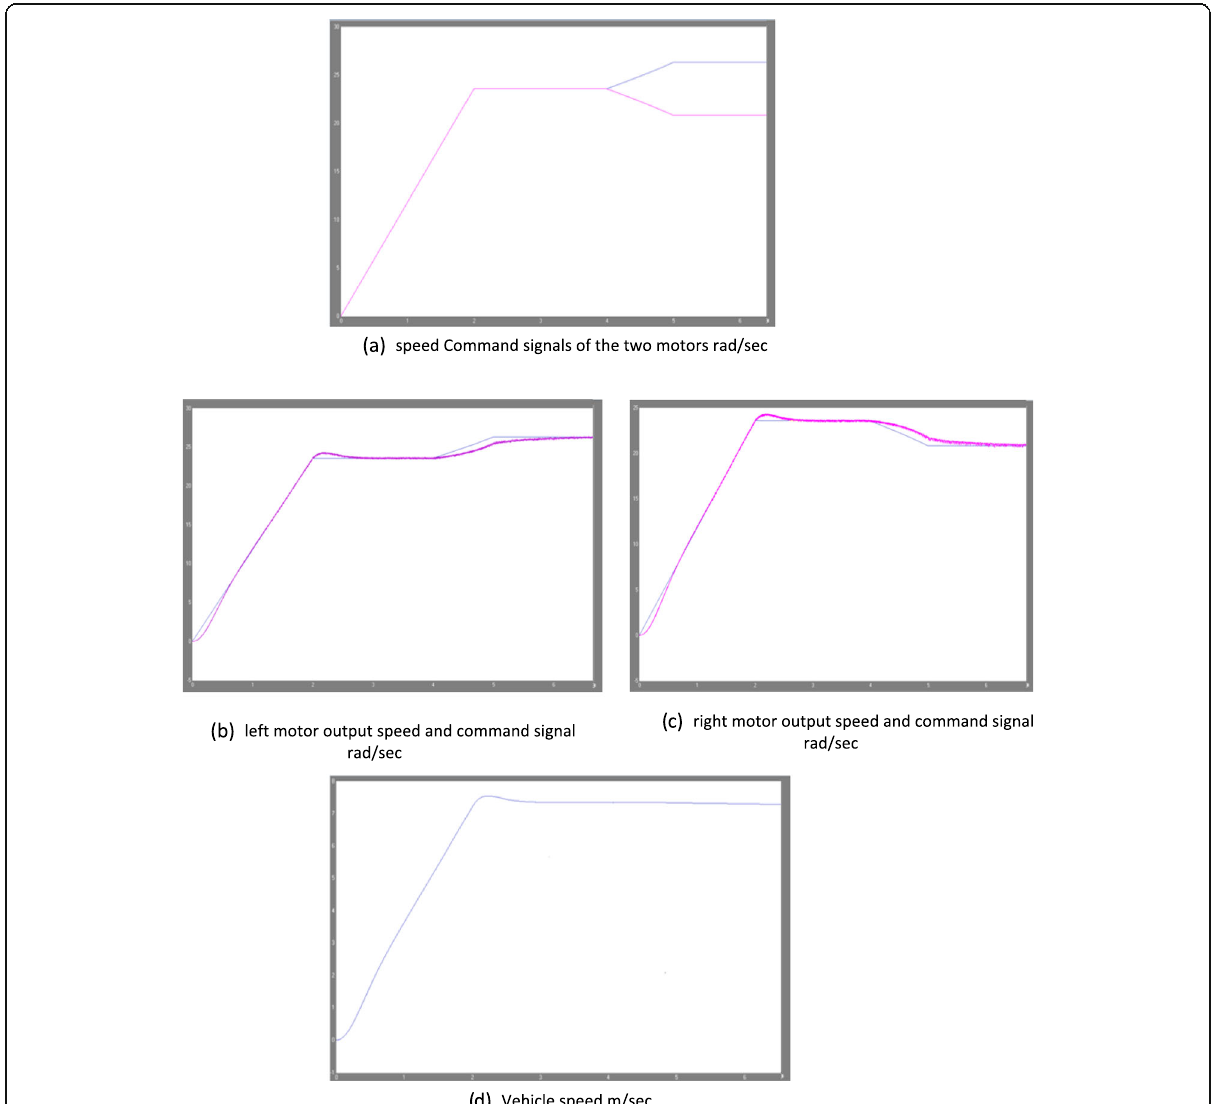
Fig. 9 a Speed command signals of the two motors (rad/s). b Vehicle speed (rad/s). c Right motor output speed and command signal (rad/s). d Vehicle speed